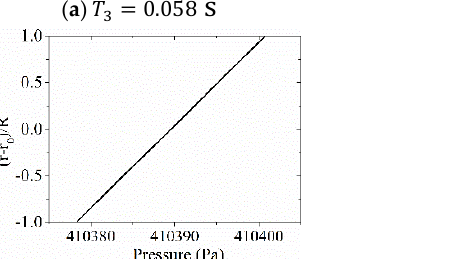
Figure 14. Local pressure distribution at S1 monitoring position of different time ( 𝑇 3 = 0.058 s and 𝑇 4 = 0.064 s ) .